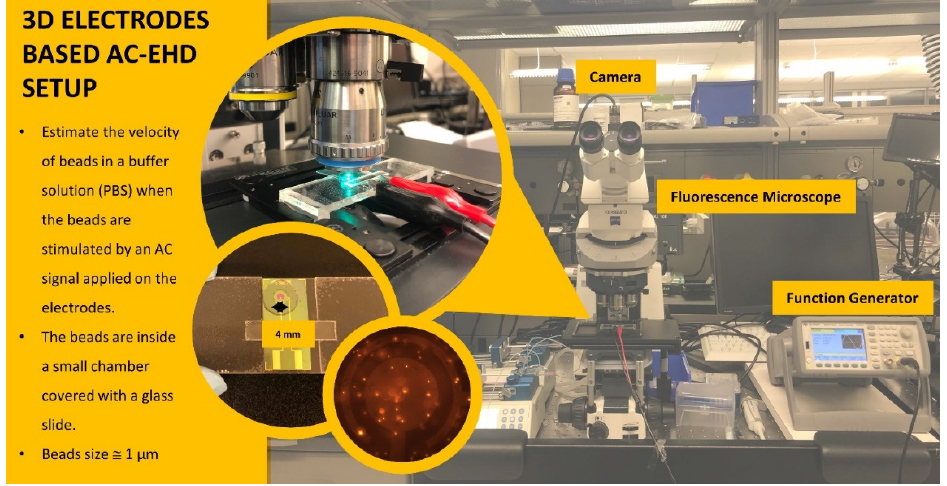
Figure 2. Schematic of the experimental setup for the characterization of 2D and 3D ac-EHD devices.